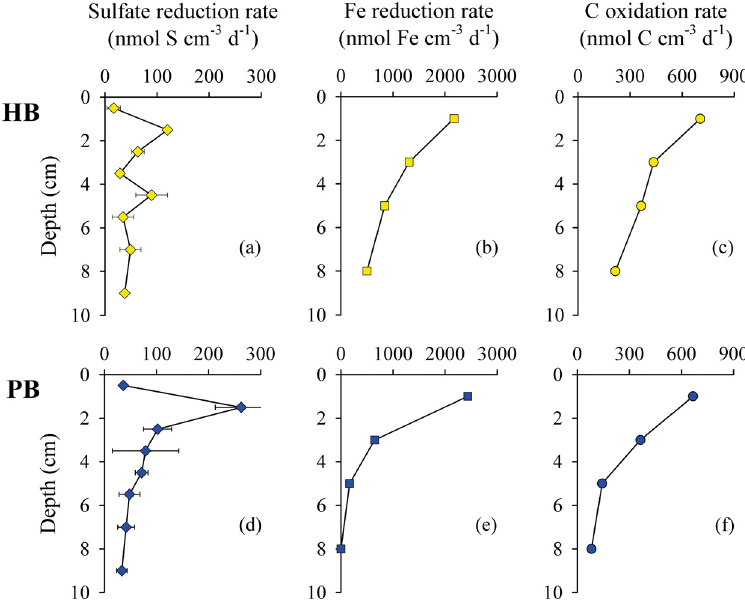
Fig. 4. Sulfate reduction from whole-core analyses, Fe reduction, and anaerobic carbon oxidation (dissolved inorganic carbon production rates) measured using anoxic bag incubation. Horizontal bars indicate SE. HB: highly bioturbated; PB: poorly bioturbated